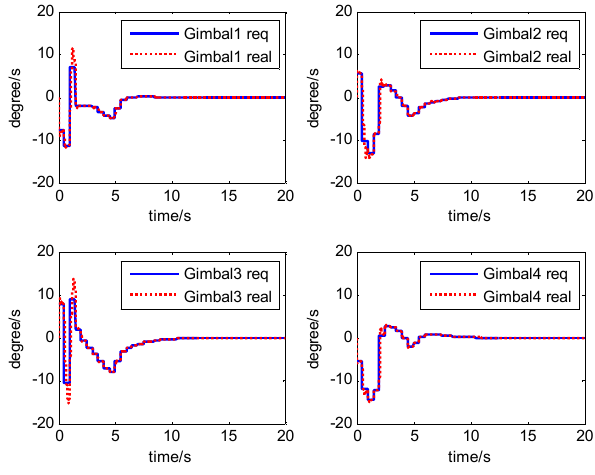
Figure 26. The gimbal rate of four magnetically suspended SGCMGs with feedforward compensation.